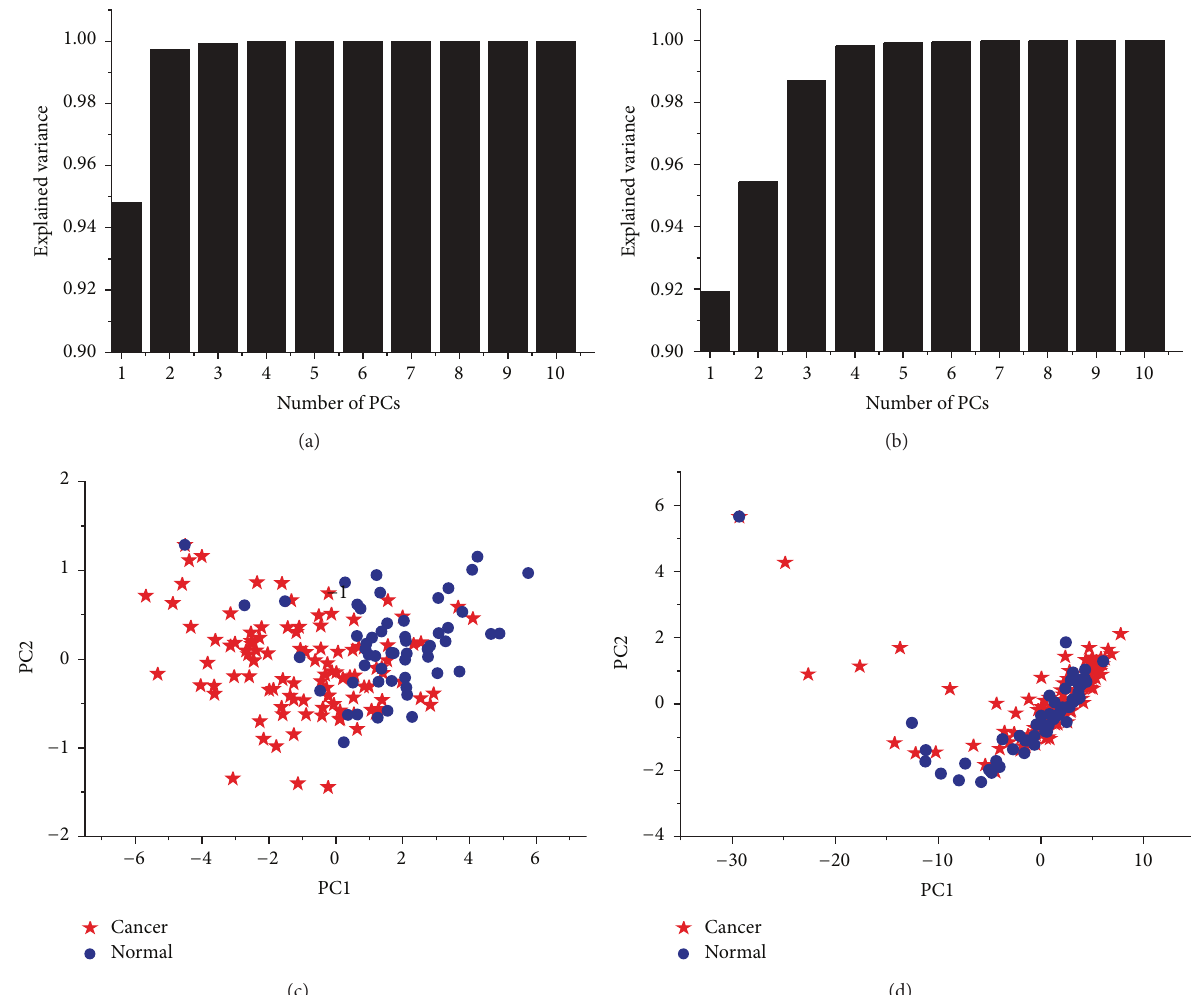
Figure 2: The explained variance versus the number of principal components and the scatter plots from principal component analysis for both original and SNV-based preprocessing